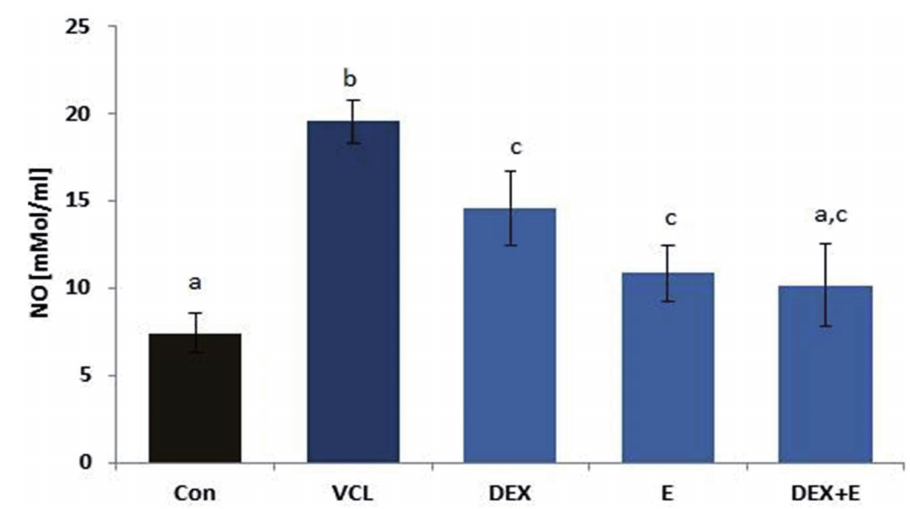
Figure 8 - Effect of VitE (150mg/kg) and DEX (0.125 mg/kg) on VCL-elevated NO level, the co-administration of VitE and DEX significantly (P<0.05) reduced testicular NO level versus non-treated animals.